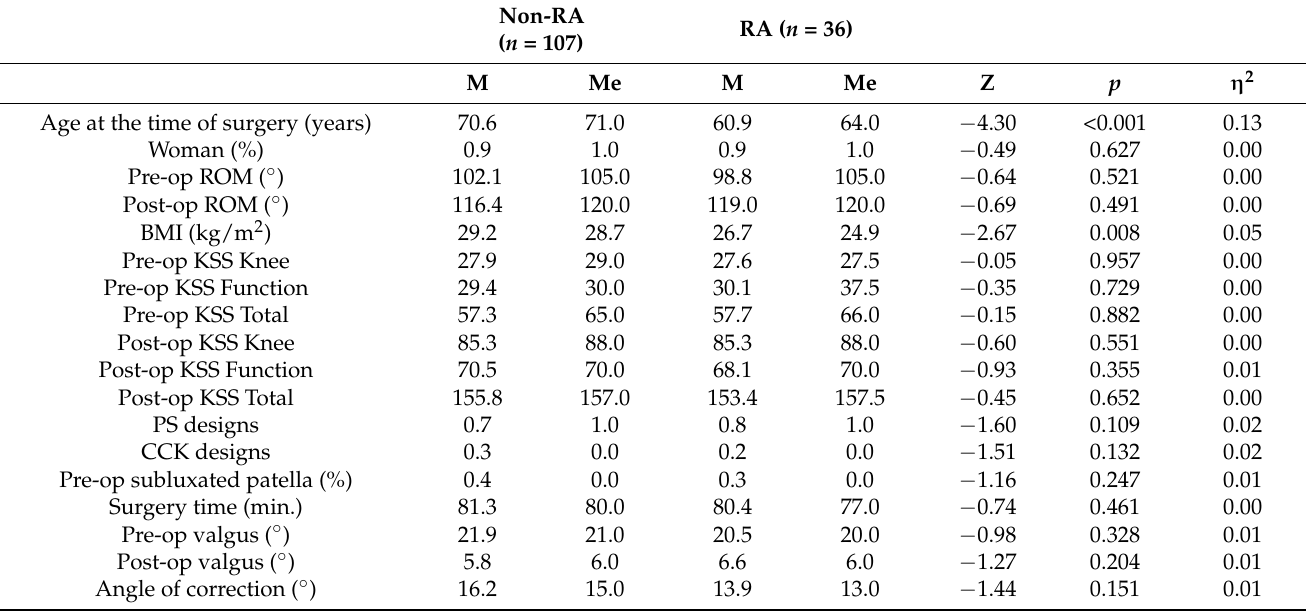
Table 4. Rheumatoid [RA] vs. non-rheumatoid [Non-RA] patients in lateral